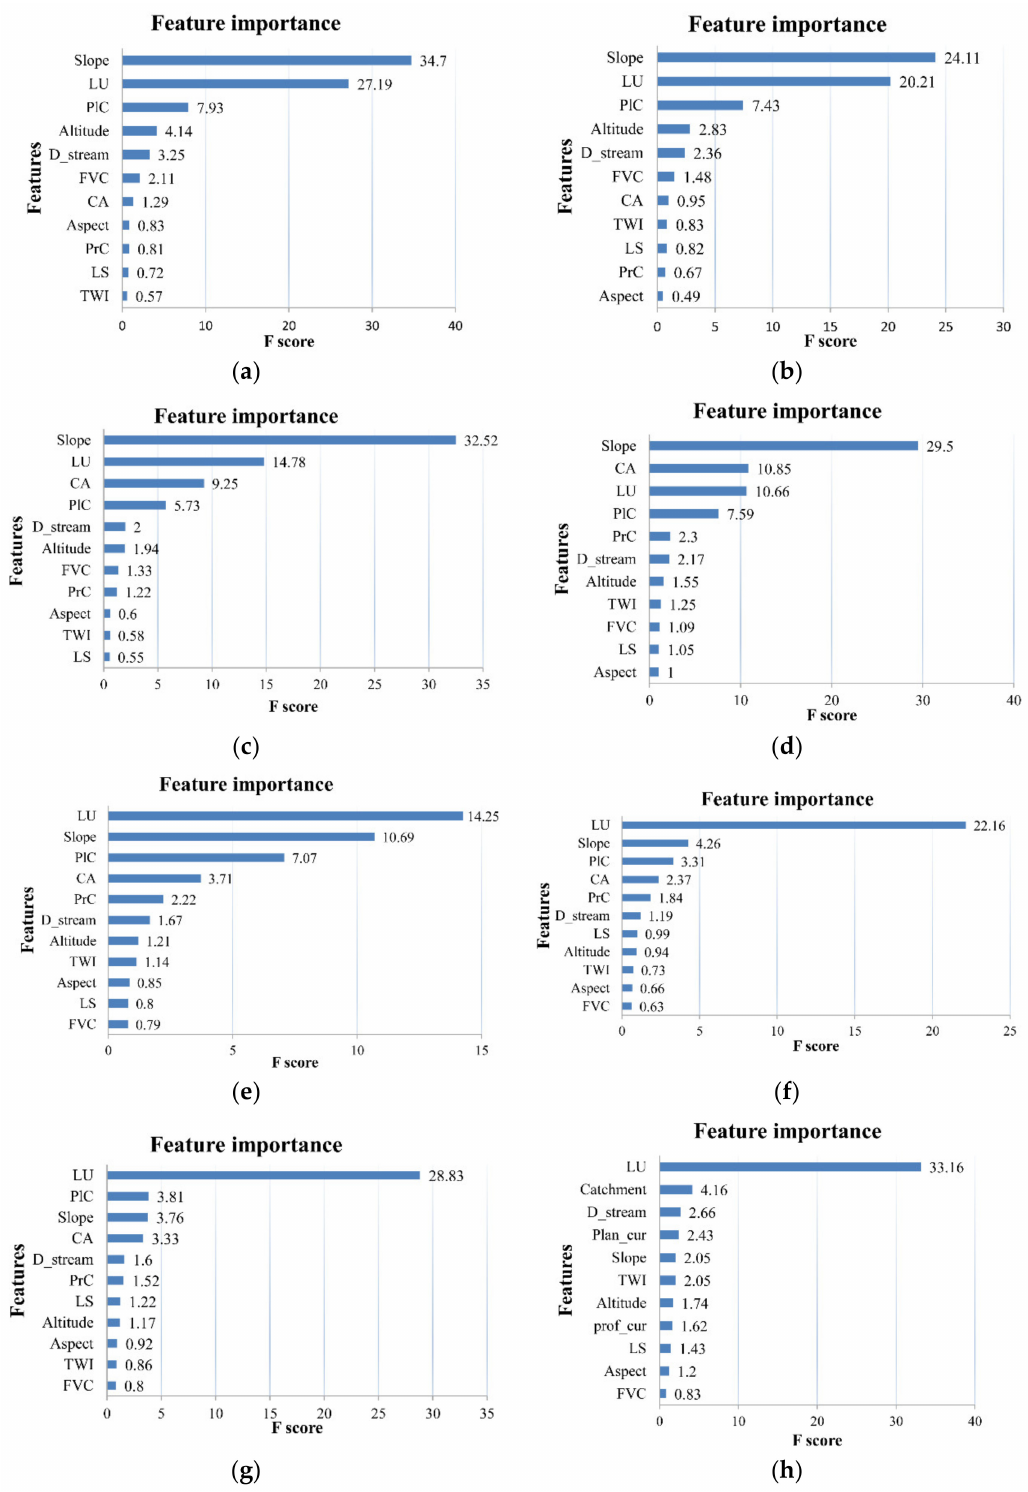
Figure 9. Variable importance at each resolution using the XGBoost algorithm. ( a ) Resolution— 0.5 m. ( b ) Resolution—1 m. ( c ) Resolution—2.5 m. ( d ) Resolution—5 m. ( e ) Resolution—10 m. ( f ) Resolution—12.5 m. ( g ) Resolution—15 m. ( h ) Resolution—30